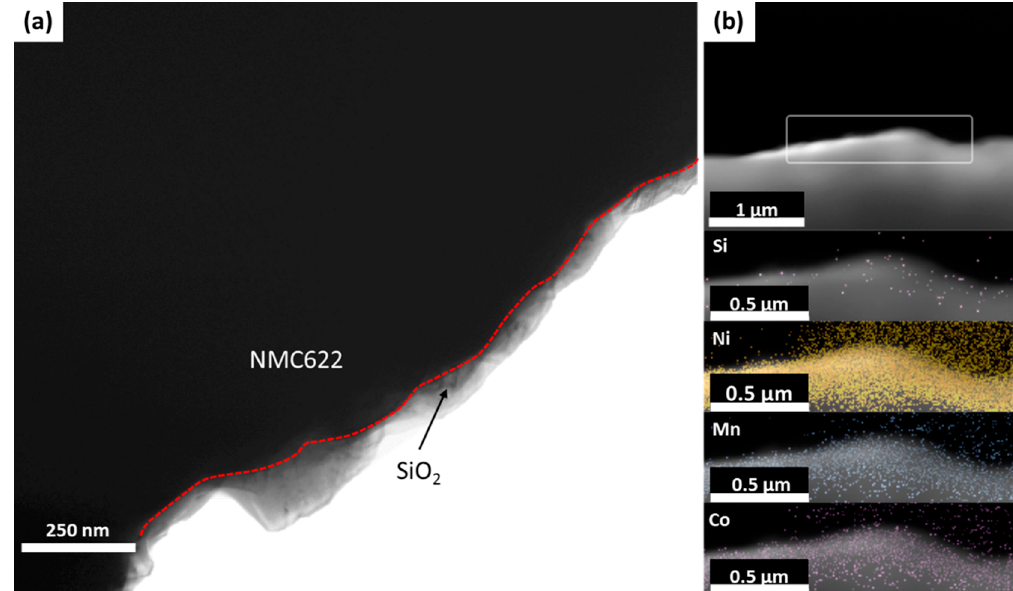
Figure 3. TEM images of ( a ) SiO 2 -coated NMC622 particle edge and ( b ) elemental mapping by EDX.